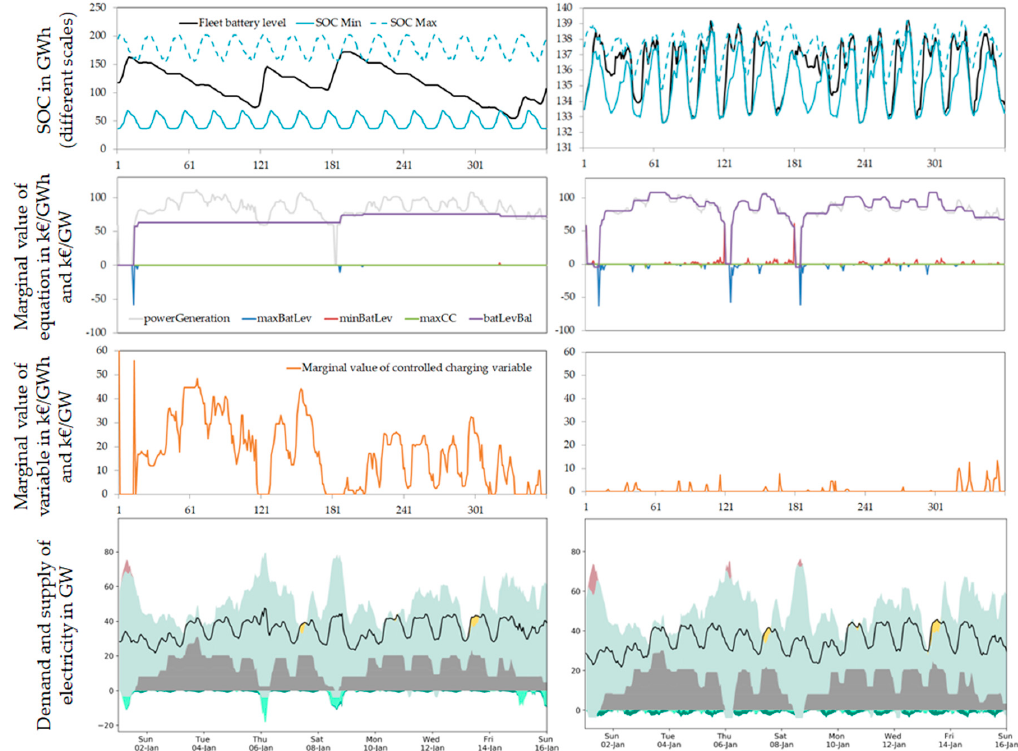
Figure A9. Marginality analysis of first 15 days (360 h) in the scenario for 2030 comparing scenario S1 (VencoPy input) ( left ) and scenario S2 (CURRENT input) ( right ) for Northern Germany. In the first row, EV fleet SOC constraints (turquoise) and levels (black) are depicted. The second-row plots show the marginal values of the equations of the REMix module and the power generation marginal for Northern Germany. The third row shows the marginal value of the controlled charging variable. The fourth row shows the power plant dispatch in Germany with fossil power plant dispatch in grey, renewables in shaded green, and curtailment in shaded red, imports in yellow. Uncontrolled charging is in dark turquoise while controlled charging is in light turquoise. The demand line comprises both electricity demand by households, industry, and service sector as well as EV charging demand. Duration curves of all marginal are shown in Figure A12–A14.